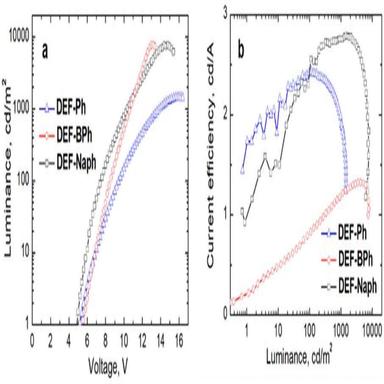
Luminance – Voltage (a) and Current efficiency – Luminance (b) OLED characteristics of the devices with the configuration: ITO/HTL of DEF-Ph, DEF-BPh or DEF-Naph/Alq3/LiF/Al.